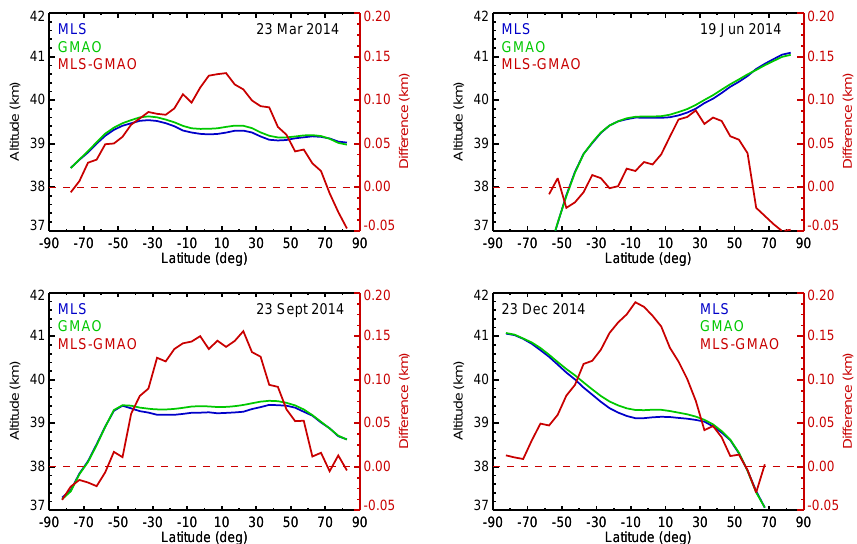
Figure 12. Daily 5 ◦ zonal means of GPH from MLS (blue) and GMAO (green), and the difference MLS–GMAO (red) at 3hPa GPH for 4 cardinal days. Note that despite a 2–4km change over an orbit, the differences are generally within 200m. These differences provide an estimate of the errors caused by the use of MERRA GPH in our radiative transfer calculations. Better agreement seen at the poles may simply be due to the fact that there are not many measurements at these latitudes and both may be influenced by the same climatology. If this error were attributed solely to the limb model and only at one altitude, the resulting TH error would be less than ± 200m. There is no evidence of either seasonal or north–south bias in the comparison, meaning that it is not clear how these GPH errors influence the ARRM results seen in Fig.